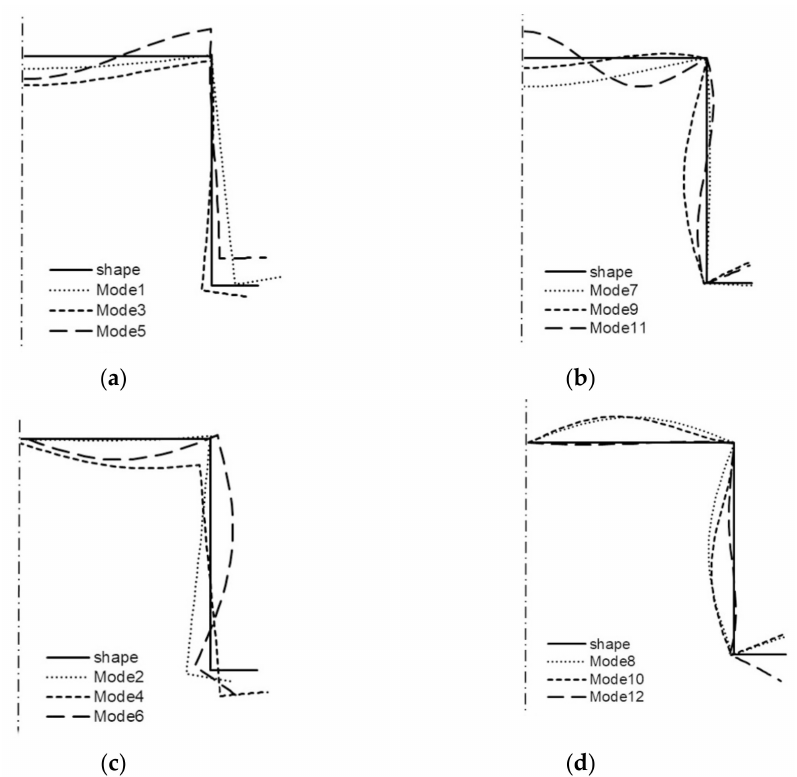
Figure 19. Buckling modes for the TH-channel of total length 330 mm (Table 7): symmetrical modes 1, 3, 5 ( a ), modes 7, 9, 11 ( b ), and anti-symmetrical modes 2, 4, 6 ( c ), modes 8, 10, 12 ( d